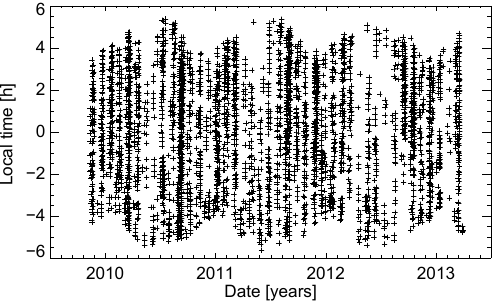
Figure 1. Coverage of the X-shooter data set between October 2009 and March 2013. The black crosses show all available X-shooter observations that have an exposure time of at least 10min. The or- dinate shows the observing time with 0 labelling local midnight. Figure 2. Example of an FeO spectrum. (a) Displays a raw night-